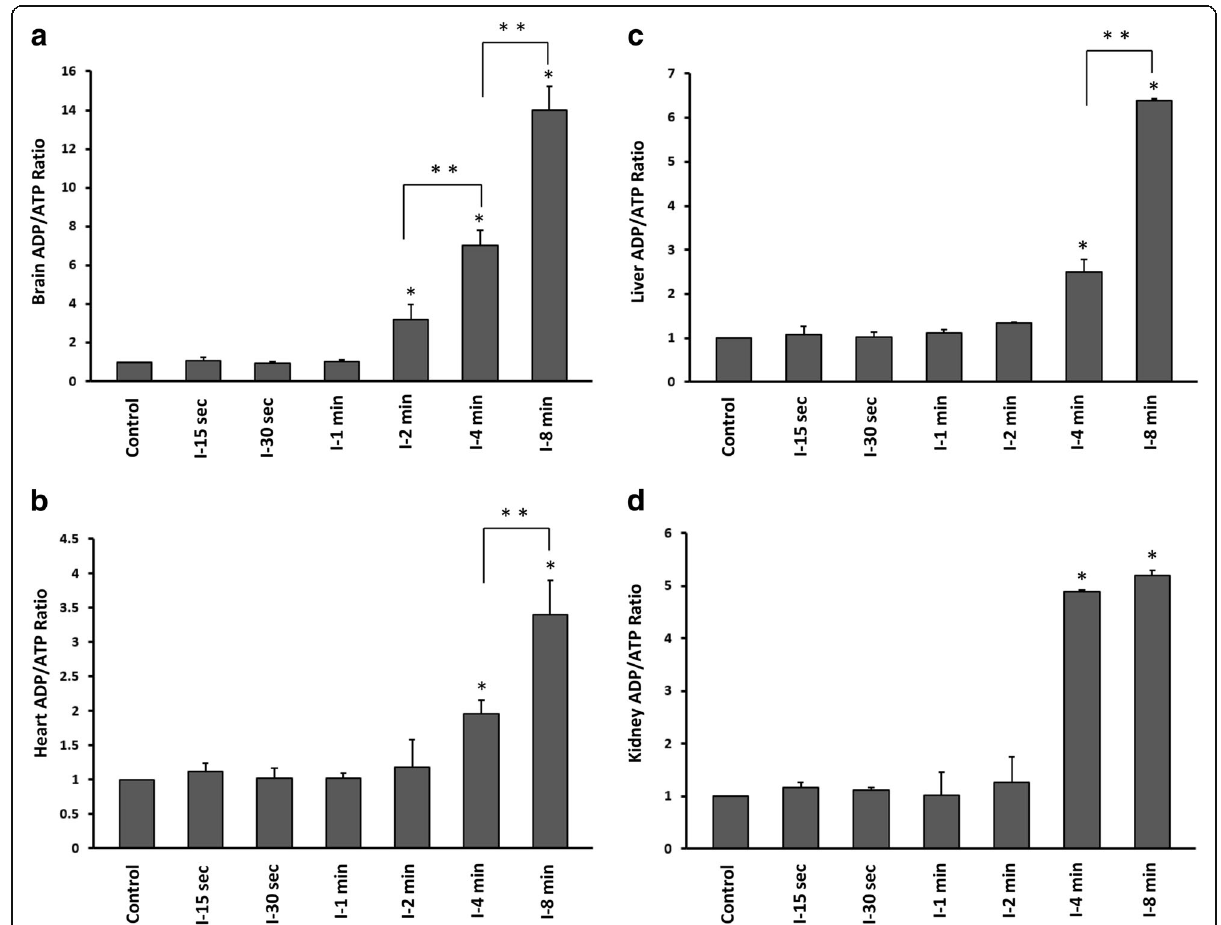
Fig. 2 ADP/ATP ratio in six groups of time-dependent ischaemia and control group (anaesthesia only). a Brain b Heart c Liver d Kidney. I-15 s: 15 s ischemia, I-30 s: 30 s ischemia, I-1 min: 1 min ischemia, I-2 min: 2 min ischemia, I-4 min: 4 min ischemia, I-8 min: 8 min ischemia * p < 0.001 all groups vs control (One Way ANOVA, followed by post hoc Tukey ’ s). ** p < 0.01 I-8 min vs I-4 min and I-4 min vs I-2 min ischaemia (One Way ANOVA followed by post hoc Tukey ’ s). Error bars depict the